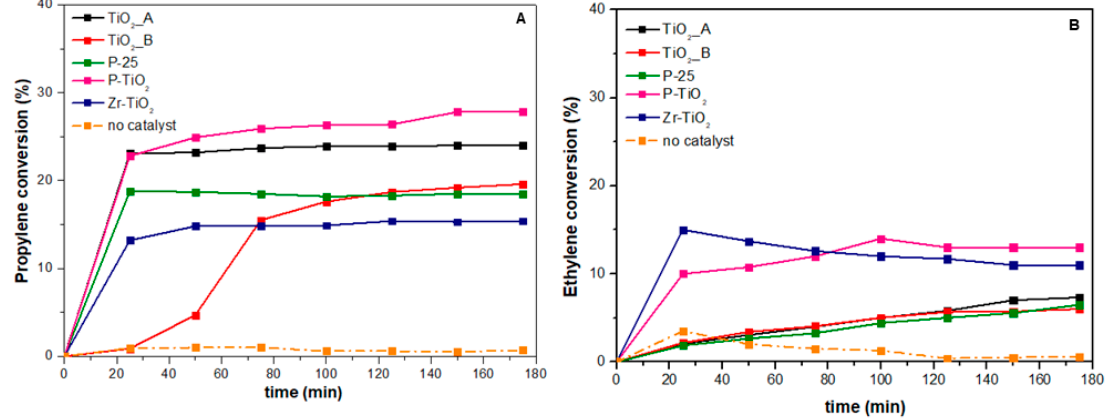
Figure 10. Trends of the propylene ( A ) and ethylene ( B ) conversions (%) over the time-on-stream. Table 7. Conversions (%) of propylene and ethylene under UV-Vis light (TOS = 3 h). Sample Propylene Conversion